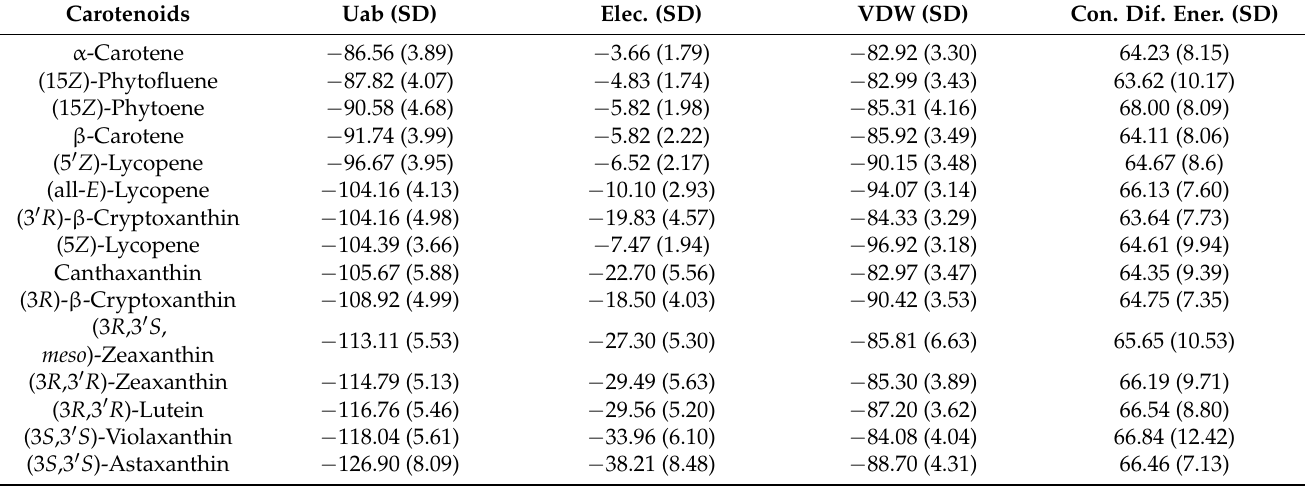
Table 6. Averages of the system–ligand interaction energies (Uab) in Kcal.mol − 1 and standard deviation (SD) between BCO2 and the ligands listed in the first column, for 1 ns of production. Total potential interaction energy, electrostatic and Van der Waals contributions are shown. The fifth column corresponds to the difference in conformational energies. This is the average value of the difference in energies between the minimum and the pose adopted at the binding site at each sampling step.